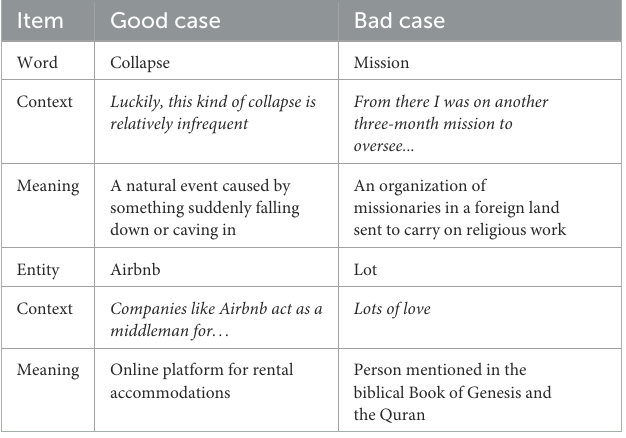
TABLE 1 Articles in the case studies.